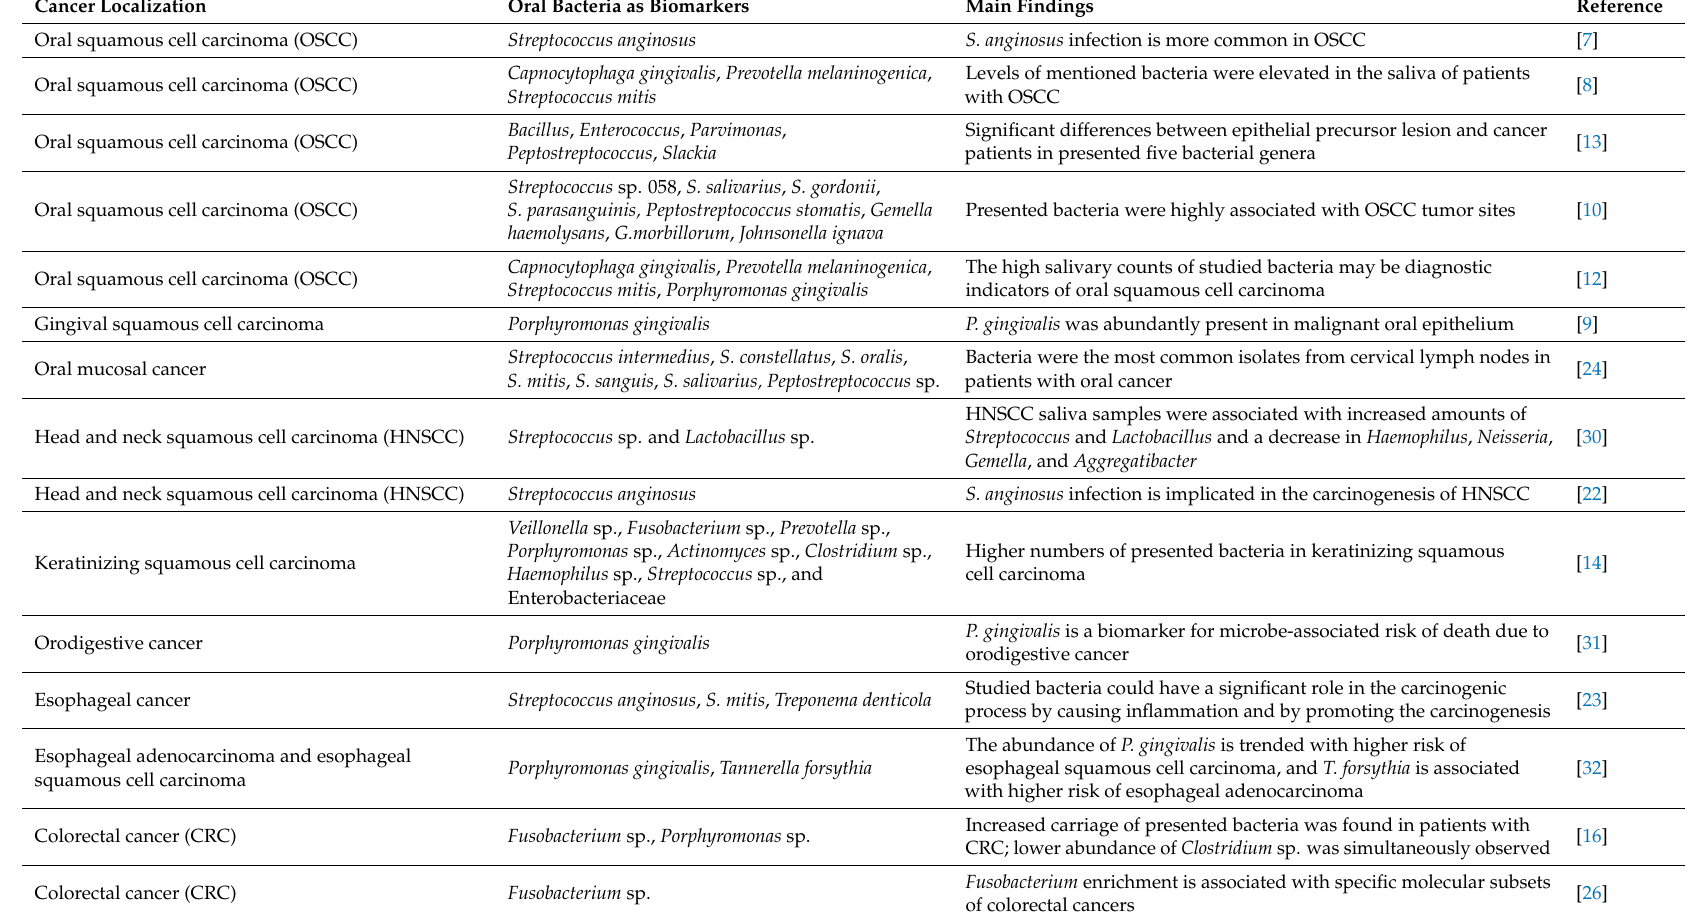
Table 1. Oral bacteria as biomarkers of specific cancer